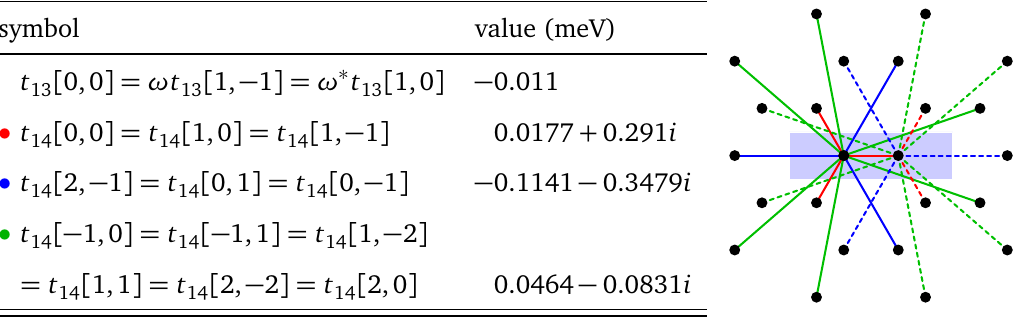
Table 1: Hopping amplitudes used in this work. They are the most important am- plitudes computed in Ref. [ 1 ] . Here ω = e 2 π i / 3 and the vector [ a , b ] following the symbol represents the bond vectors in the ( E t t ∗ and t t ∗ . On the right: schematic view of the hopping terms t 23 = 24 = 14 13 a given layer (the unit cell is the blue shaded area). Lines 2, 3, and 4 of the table correspond to the red, blue and green links, respectively. Dashed and full lines are for t and t , 14 23